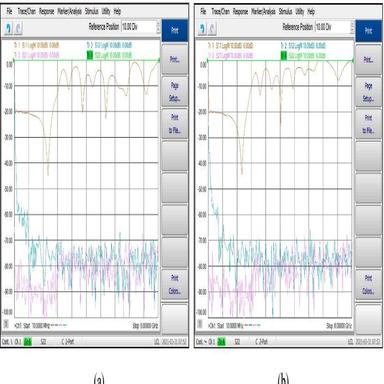
Measured S parameter: (a) return loss at port 1; (b) return loss at port 2.